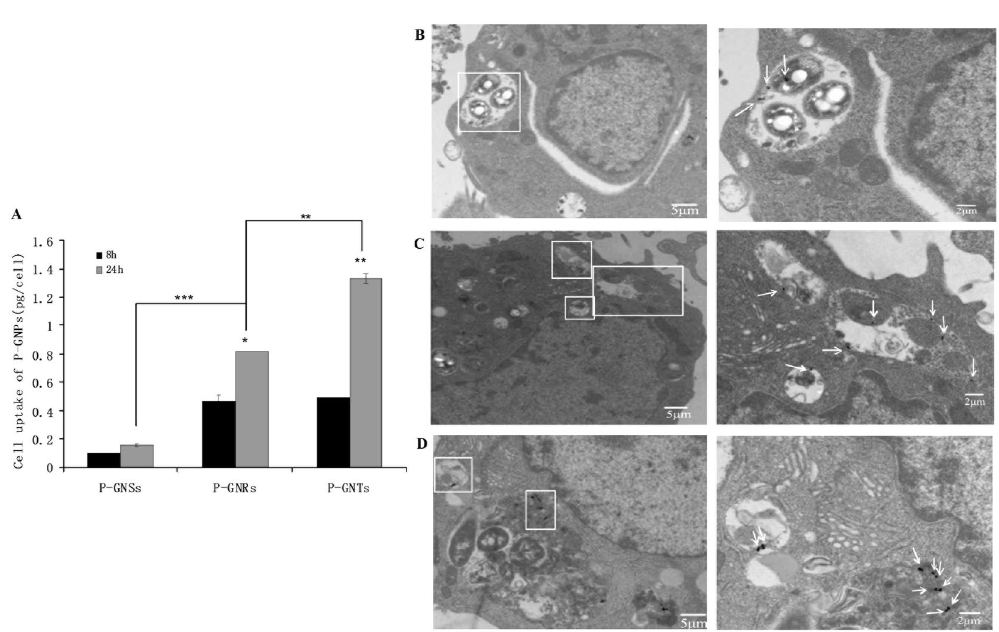
Figure 5. Cellular uptake of P-GNPs( A ) and TEM images of RAW 264.7 after 24 h of incubation with P-GNSs( B ), P-GNRs( C ), P-GNTs( D ). Data represent mean ± SEM (n = 3). Statistical significance is represented by * p < 0.05, ** p < 0.01, *** p <